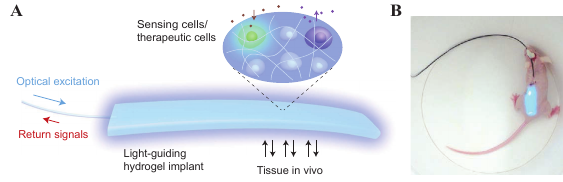
Fig. 8. Hydrogel-based active optical waveguiding devices. (A) A schematic for the cell-integrated optical waveguide. (B) A hydrogel- implanted mouse in a freely moving state with a blue light coupled. Reprinted by permission from [42], Copyright 2013, Macmillan Pub- lishers